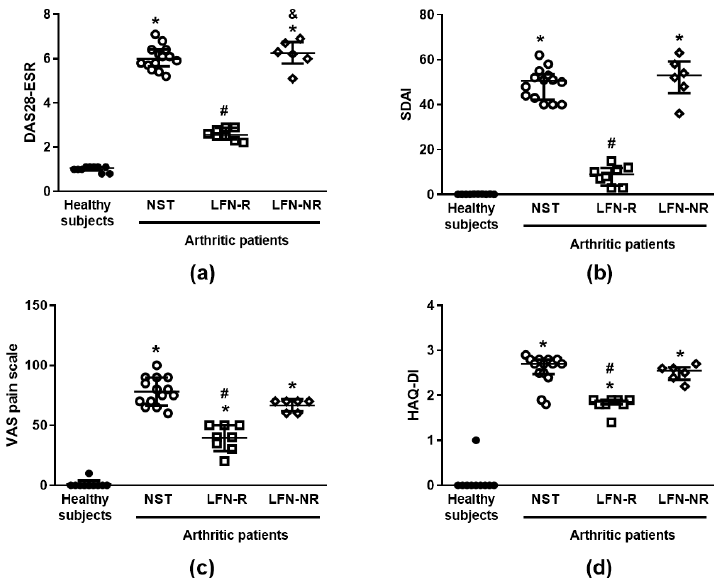
Figure 1. Disease activity indexes. ( a ) Disease Activity Score-28 for Rheumatoid Arthritis with erythrocyte sedimentation rate (ESR) (DAS28-ESR), ( b ) Simplified Disease Activity Index for Rheumatoid Arthritis (SDAI), ( c ) visual analog scale (VAS) and ( d ) Stanford Health Questionnaire–disability index (HAQ-DI) in patients with rheumatoid arthritis (RA) treated with leflunomide (LFN; 20 mg/day, per os ). The scores were recorded from patients recently diagnosed with RA but not yet receiving specific treatment with anti-rheumatic drugs prior to (non-specific therapy (NST) group; n = 14) and three-months after LFN treatment. Patients presenting at least a 50% reduction of the disease activity indexes and at least a 30% reduction of the pain and/or disability scores following treatment were considered as responders to LFN (LFN-R; n = 8). Those with high disease activity indexes (DAS28-ESR and SDAI) and with less than 30% reduction in the VAS and HAQ-DI scores after three-months of LFN treatment were considered as non-responders (LFN-NR; n = 6). Healthy subjects ( n = 10) were used as controls. Data are expressed as scatter plots with mean ± SD (panel c ) or median and 25th–75th percentile (IQR; panels a , b and d ). ∗ p < 0.05, differs from healthy subjects; # p < 0.05, differs from prior to therapy (NST group); & p < 0.05, differs from the LFN-R group.